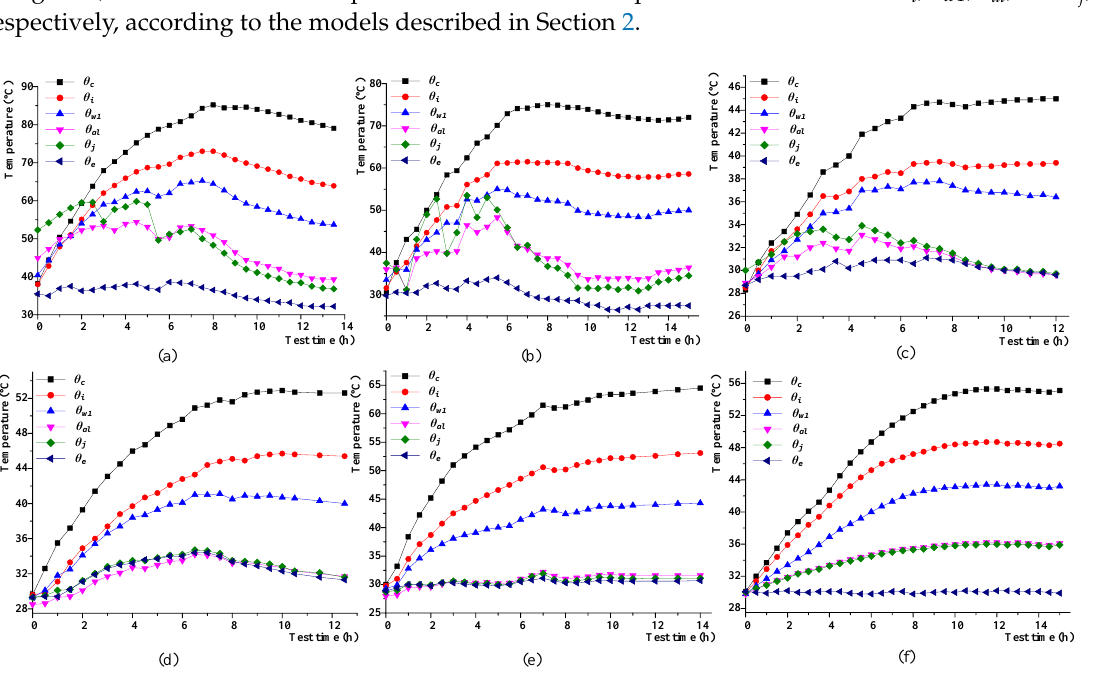
Figure 7. Measured temperatures of different radial positions in the cable and environment: ( a )–( f ) represent Cases 1–6.